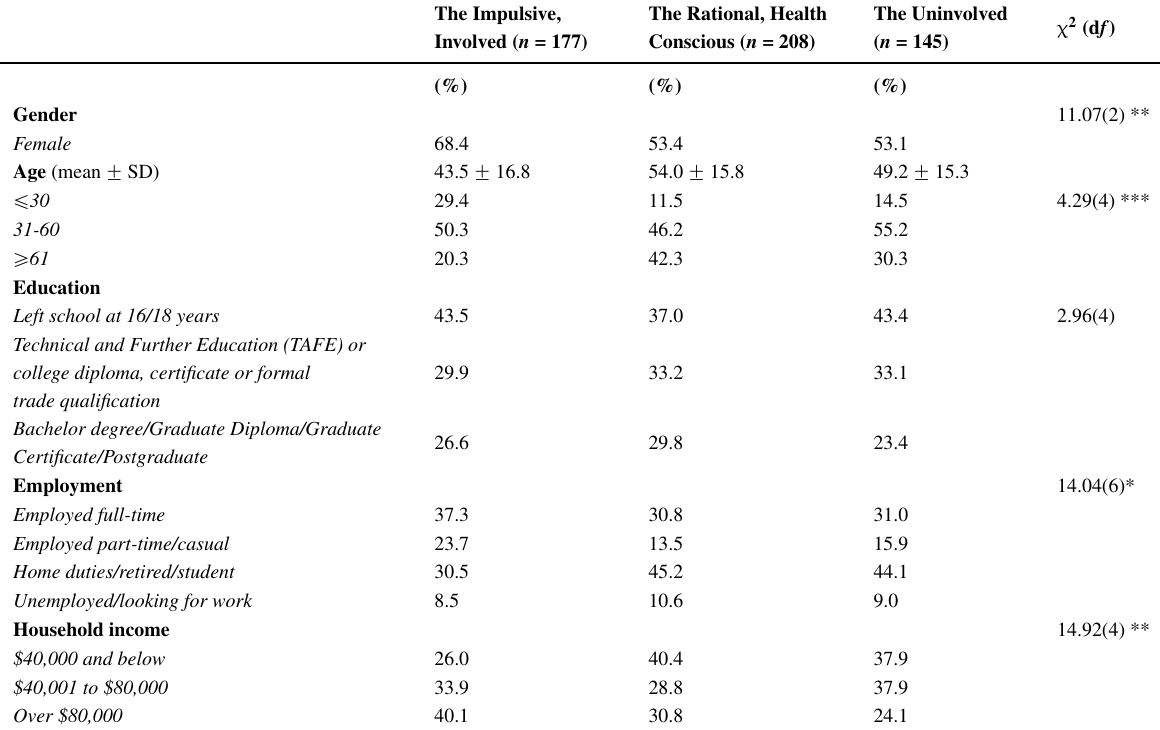
Table 5. Socio-demographic characteristics of the